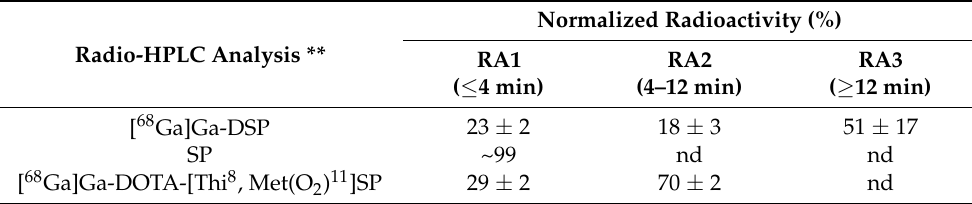
Figure 2. Radio-HPLC analysis of ( a ) [ 68 Ga]Ga-DOTA-[Thi 8 , Met(O 2 ) 11 ]SP and ( b ) [ 68 Ga]Ga-DSP. Table 1. Radio-chromatographic analysis of crude [ 68 Ga]Ga-peptides